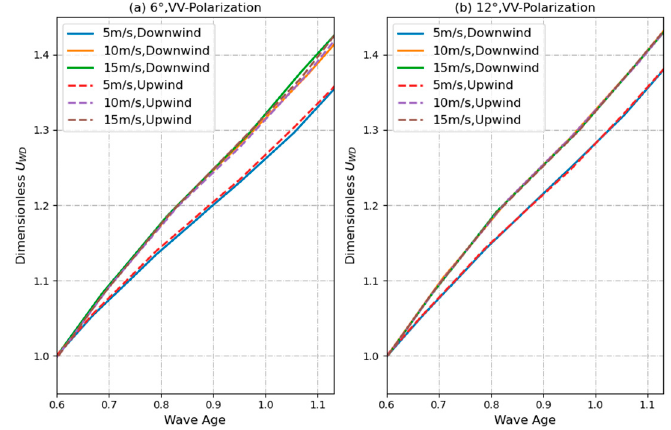
Figure 16. Contribution of wave age to U WD at 5, 10, and 15 m/s wind speeds with radar incidence angles of 6° and 12°, radar azimuth of 0°, wind directions of 0° and 180°, and no swell. The colored solid lines indicate U WD, the black lines indicate Csp , and the corresponding colored shading is the standard deviation.